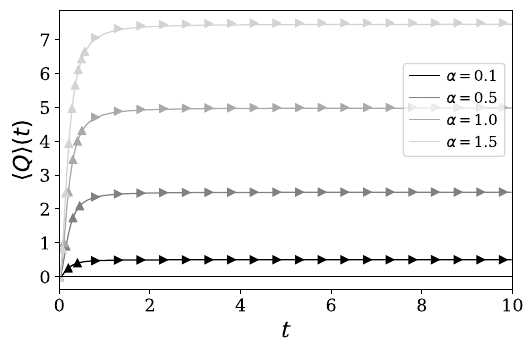
FIG. 2. Variance of the heat dissipated into the bath as a func- tion of time in the independent-boson model. The solid lines are the second cumulant calculated numerically for the values of the temperature and coupling strength indicated. The triangu- lar markers are the corresponding analytical results given by Eq. (B11), l = 1. The spin splitting is set to ω 0 = 1 and the bath cut- off is ω C = 5. The parameters controlling the numerical accuracy are K (cid:6) = 5, (cid:6) = 0.01, and p = 100. The derivative is taken at u = 0.01 for α = 0.1 and at u = 0.005 for α =